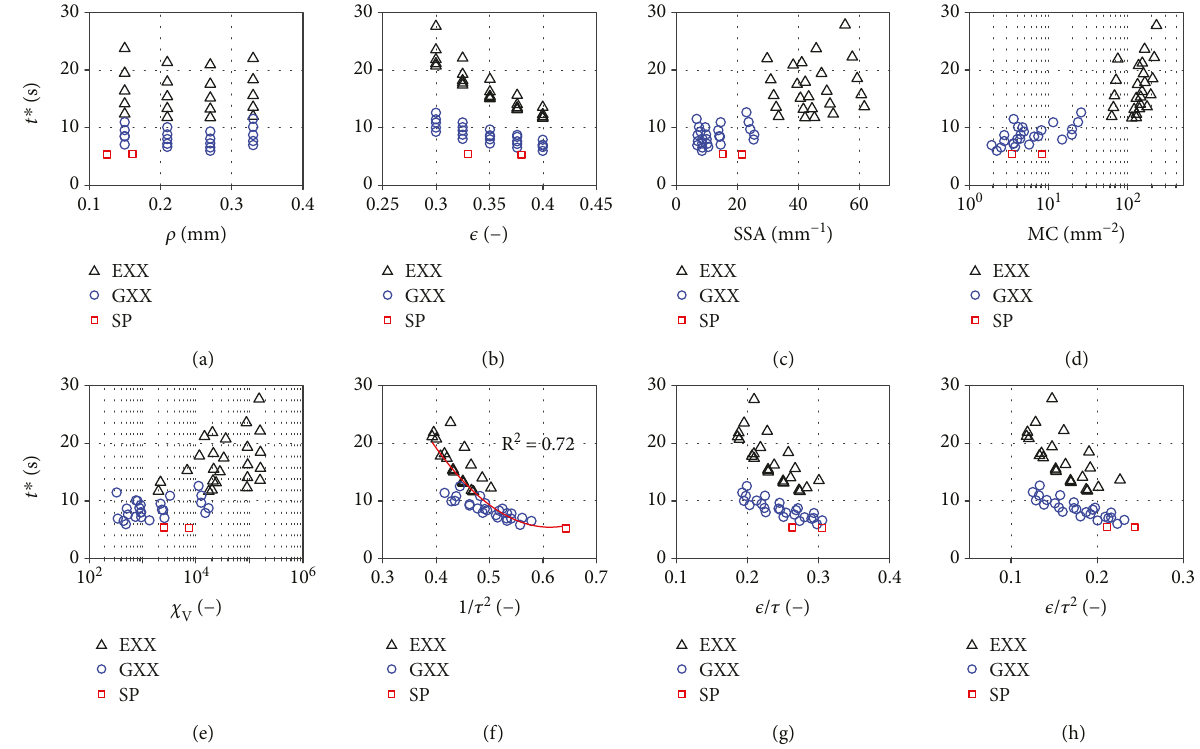
Figure 6: t ∗ as a function of correlation length ( ξ ), Minkowski functionals — porosity ( φ ), speci fi c surface area (SSA), mean curvature (MC), ) — and literature relationships for e ff ective di ff usivity, 1/ τ 2 , ϕ / τ , and ϕ / τ 2 , respectively, for generated porous media and Euler number ( χ V (black triangles and blue circles for exponential (EXX) and Gaussian (GXX) variogram models, respectively) and scanned sandpacks (SP) (red squares). The coe ffi cient of determination ( R 2 ) associated to the fi tting functions for the MC (red lines) is reported in (f).